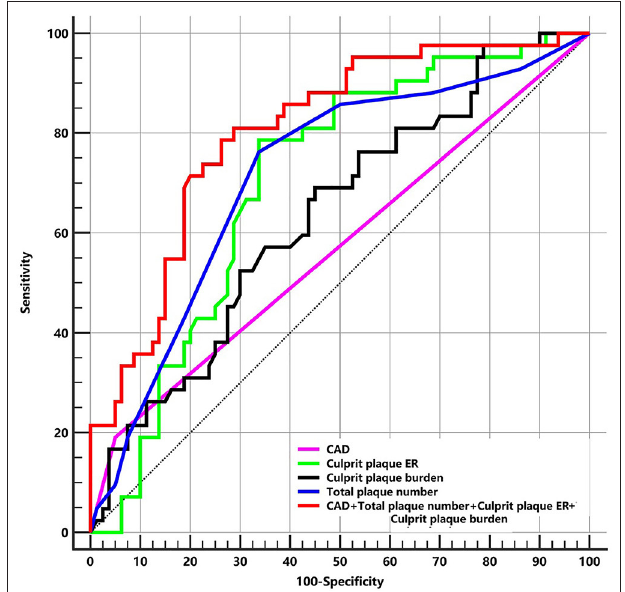
FIGURE 5 | The ROC of plaque features for differentiating patients with the first-time and recurrent acute stroke. ER, enhancement ratio; CAD, coronary artery disease; ROC, receiver-operating characteristic curves; AUC, area under curve. CAD: AUC = 0.570. Culprit plaque ER: AUC = 0.704 (cutoff = 1.91, sensitivity = 78.57% specificity = 66.25%). Culprit plaque burden: AUC = 0.636 (cutoff = 81.60%, sensitivity = 69.05%, specificity = 55.0%). Total plaque number: AUC = 0.716 (cutoff = 4, sensitivity = 76.19%, specificity = 66.25%). CAD + Total plaque number + Culprit plaque ER + Culprit plaque burden: AUC = 0.804 (sensitivity = 78.57%, specificity =